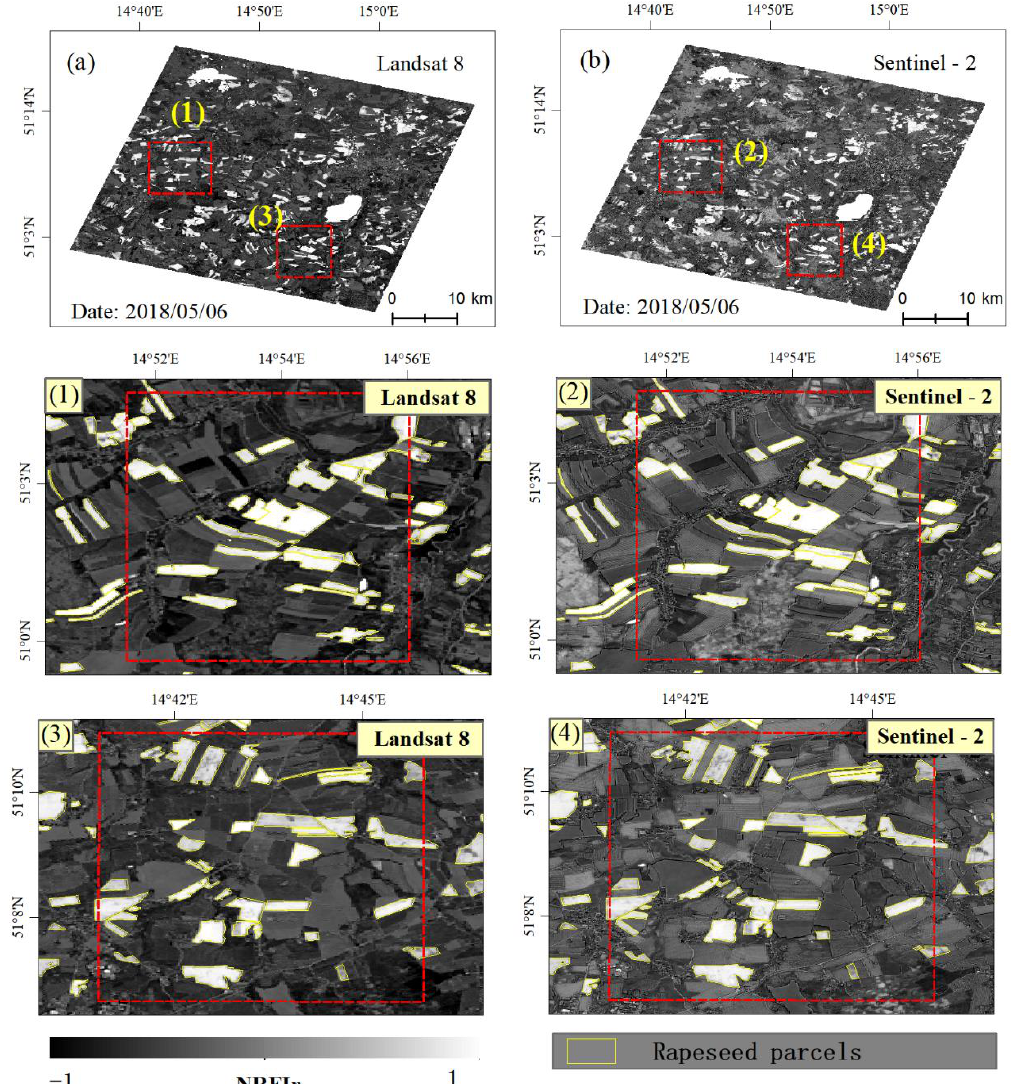
Figure 9. ( a ) NRFIr index map from Landsat 8 in the study area; ( b ) NRFIr index map from Sentinel-2 in the study area; ( 1 )–( 4 ) are partial drawings enlarged.